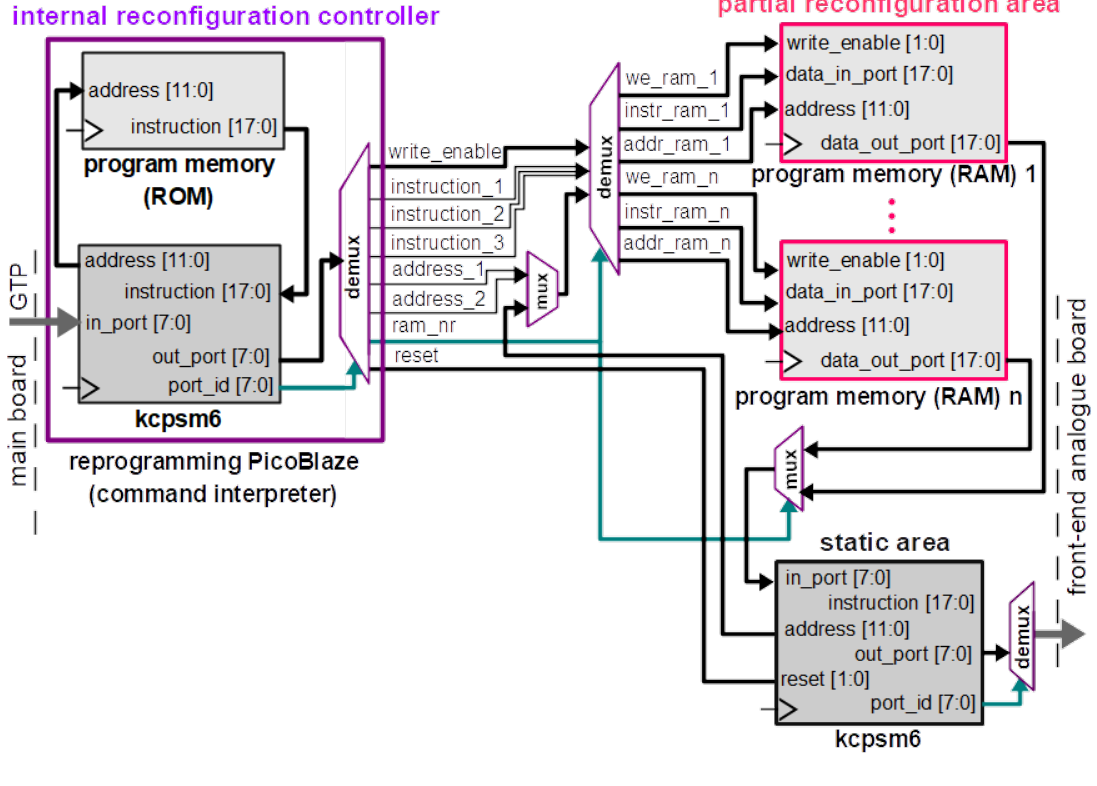
Figure 5. Dynamic reconfiguration block.